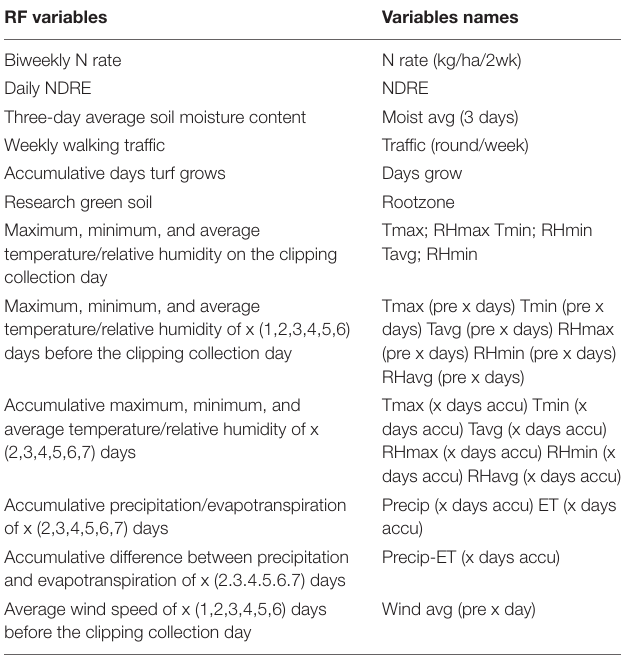
TABLE 2 | Variables used in the random forest (RF)